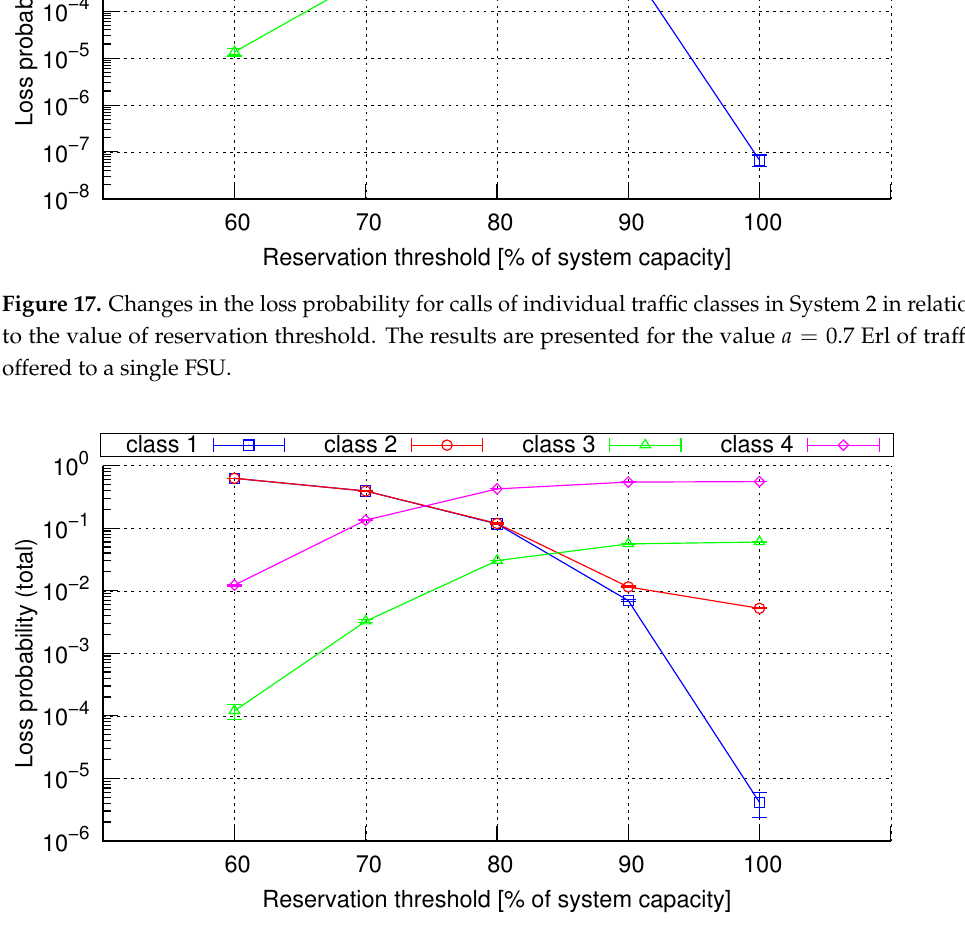
Figure 18. Changes in the loss probability for calls of individual traffic classes in System 2 in relation to the value of reservation threshold. The results are presented for the value a = 0.9 Erl of traffic offered to a single